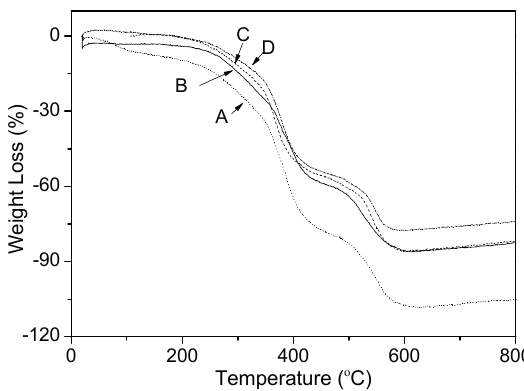
Figure 5. The TGA curves of GNS-based epoxy resin coating with different contents of (A) 0; (B) 0.1 wt %; (C) 0.4 wt %; and (D) 0.7 wt